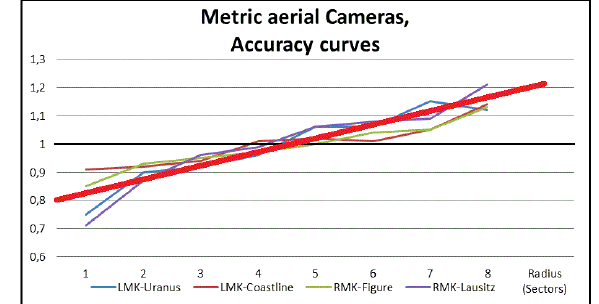
Fig. 10 Accuracy of the photogrammetric camera types with fitted line